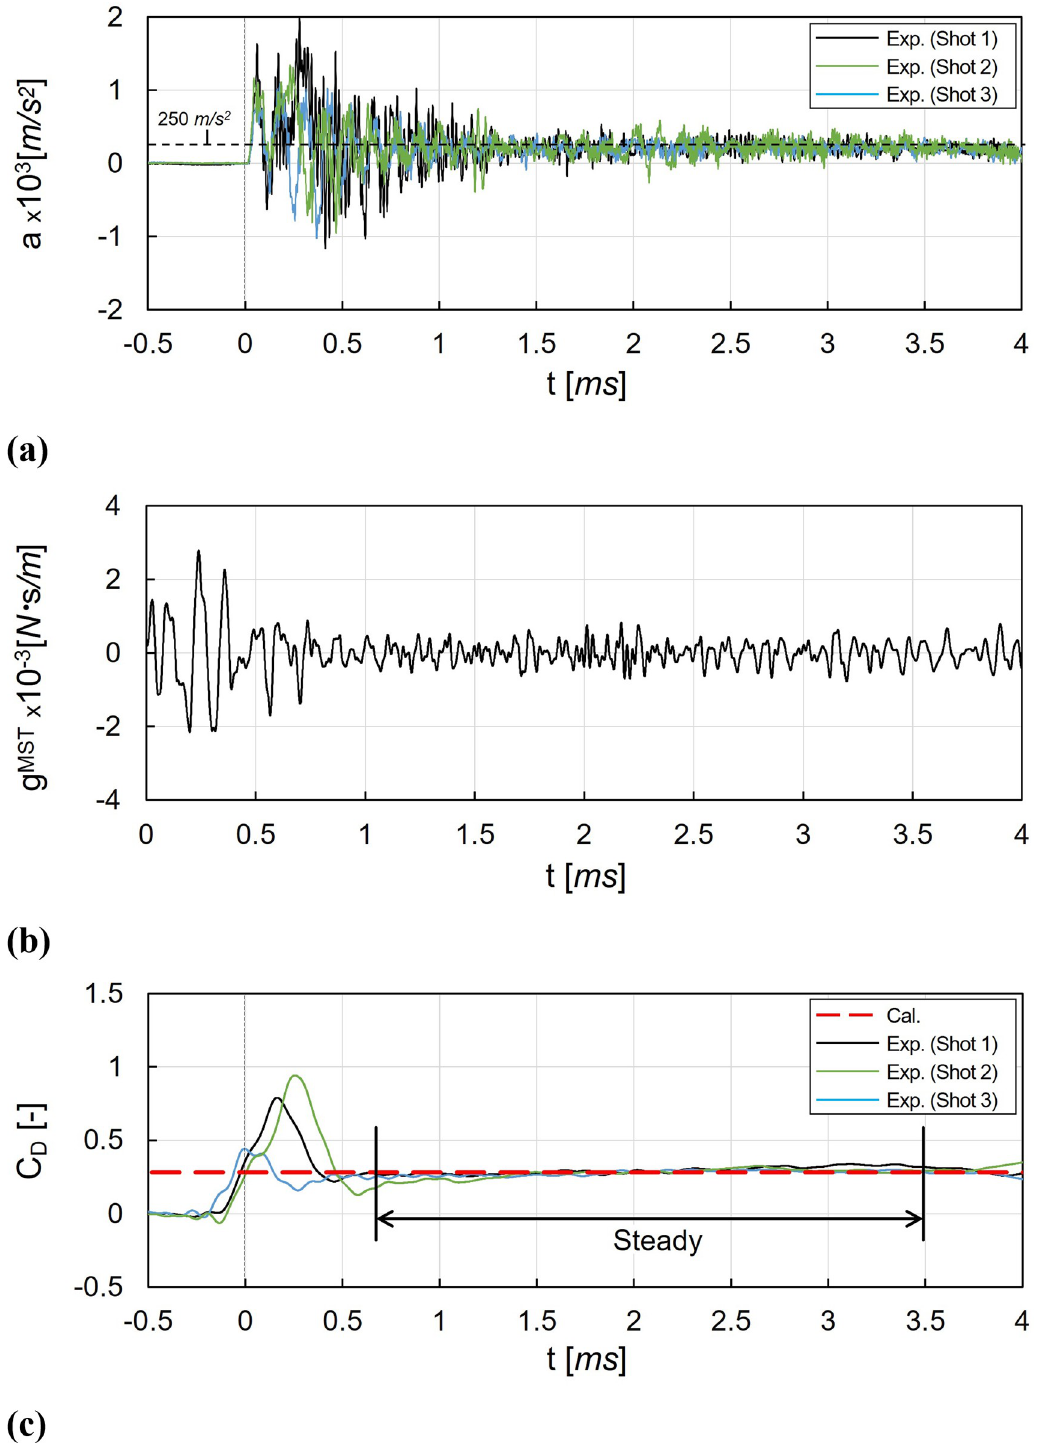
Fig 12. Drag coefficient measurements using the MST. (a) Measured acceleration, (b) Dynamic response function of the MST for 4.0 ms , (c) Recovered drag coefficient histories.